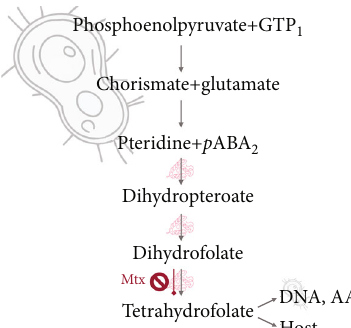
Figure 2: Bacterial route of de novo folic acid synthesis. Certain commensals of the human colonic fl ora produce folate de novo through the chorismate pathway (from phosphoenolpyruvate + guanosine triphosphate, GTP) . Further, 77% of the bacterial 1 genome is capable of synthesizing folate using freely available p- aminobenzoic acid ( p ABA) and dihydropteroate diphosphate (pteridine) [84]. The pathway engages a series of enzymatic 2 reactions (red protein symbols) including dihydropteroate synthetase and dihydrofolate synthetase. The resulting dihydrofolate (via the dihydropteroate intermediate) must be enzymatically reduced (through dihydrofolate reductase) to generate biologically active tetrahydrofolate. This process can be blocked by the folate antagonist methotrexate (Mtx), used for controlling some forms of autoimmune disease including anterior uveitis. Folate metabolites synthesized by commensals are used by the bacteria themselves (e.g., for DNA-synthesis or anabolic pathways such as generation of amino acids, AA). The remaining unused folates are released into the gut lumen and absorbed in a receptor-mediated fashion absorption into the